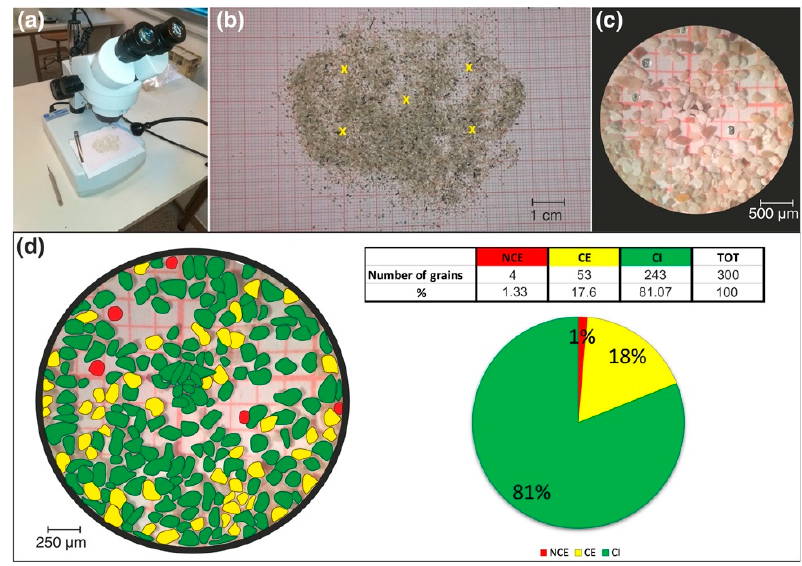
Figure 5. Example of hybrid sand composition analysis; ( a ) sand analysis at the microscope; ( b ) sample spread on a rigid base with the field locations; ( c ) field for counting method; ( d ) example of counting for sand classification, green: bioclasts, yellow: carbonate lithoclasts; red: quartz.